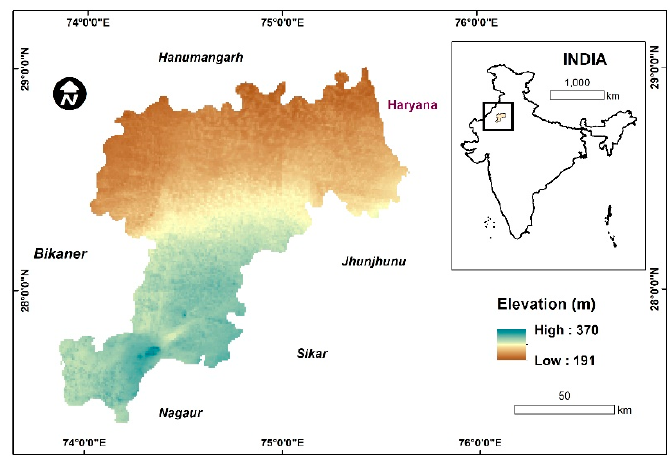
Figure 1. Location of the study area (Datum: WGS84).